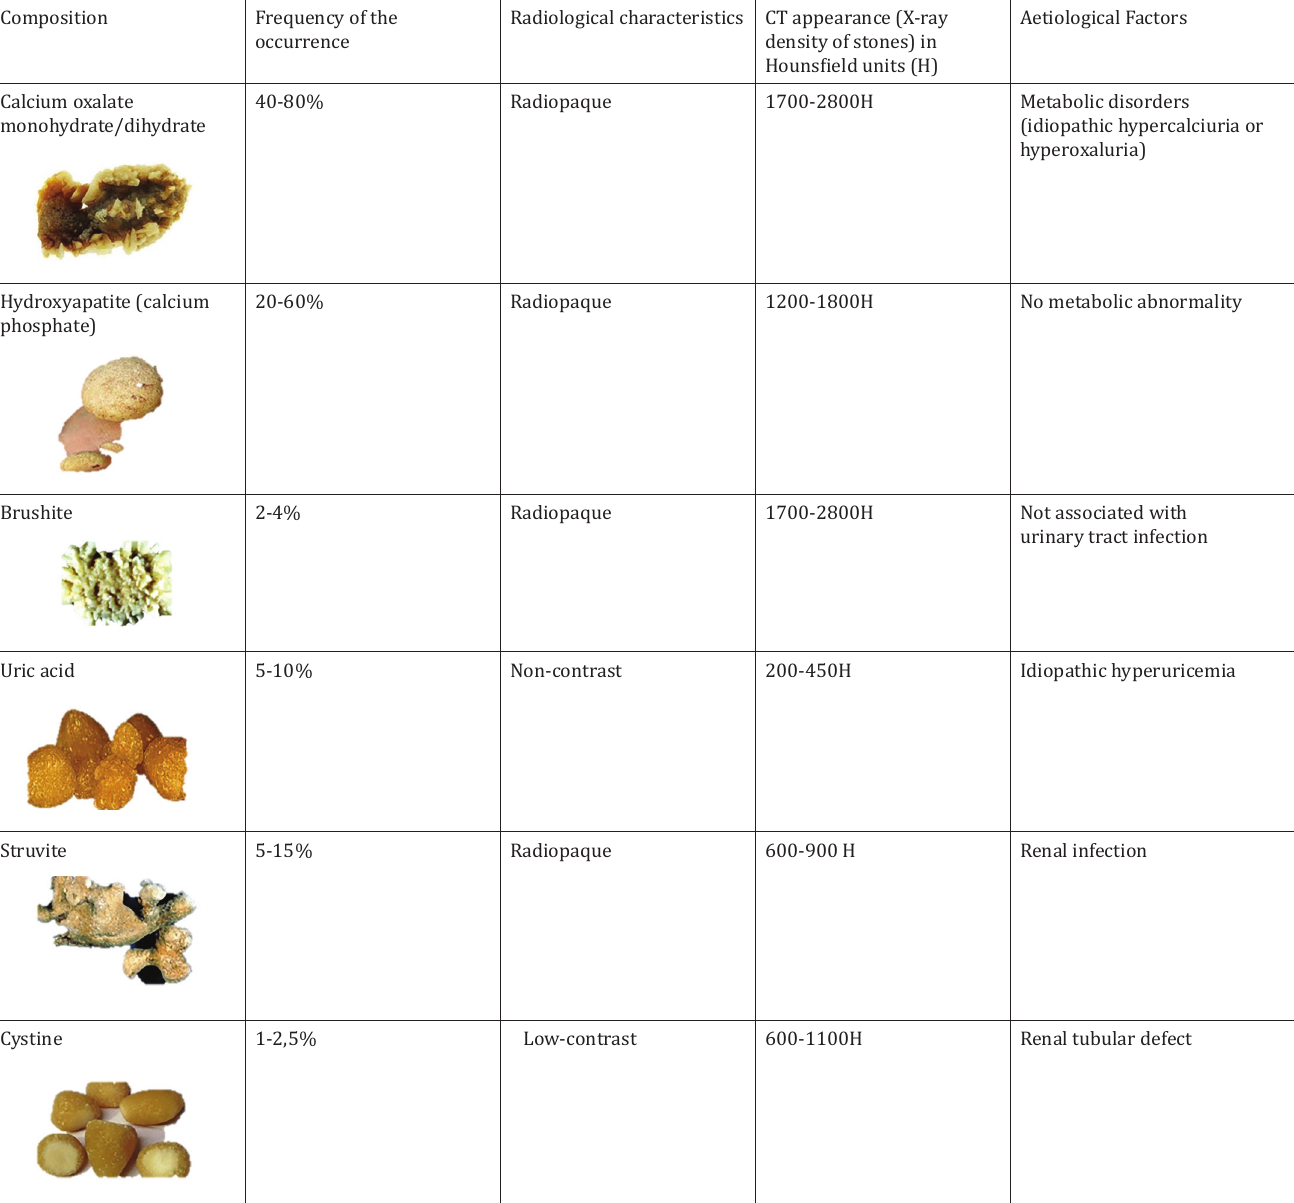
Composition Frequency of the Radiological characteristics CT appearance (X-ray occurrence density of stones)